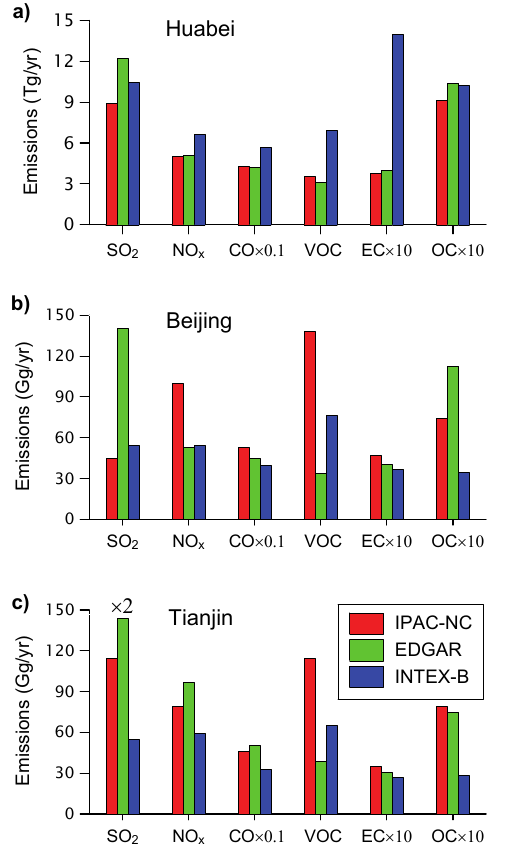
Fig. 9. Comparisons of the 2003 IPAC-NC inventory developed in this study with the 2005 EDGAR-CIRCE inventory and the 2006 INTEX-B inventory in respect of total emissions in the Huabei area (a) , the Beijing megacity area (b) , and the Tianjin megacity area (c) . See the text for detailed descriptions of the areas. Note that different scaling factors are used for CO, EC and OC in all the cases and for SO 2 in the EDGAR-CIRCE inventory for the Tianjin area.